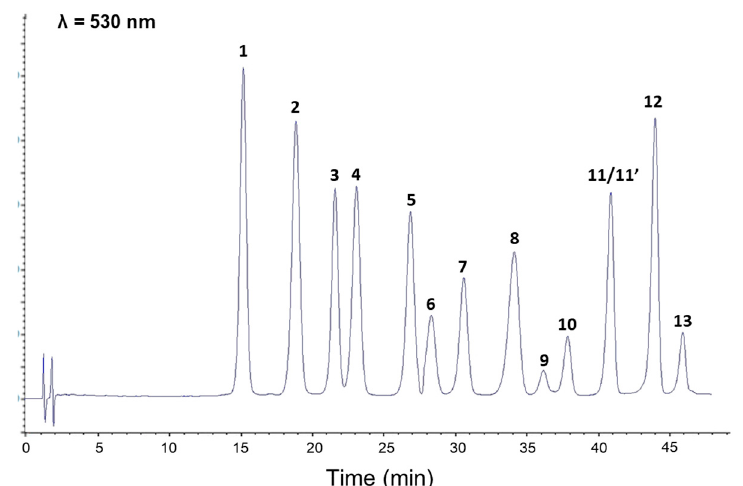
Figure 4. HPLC profile of Vaccinium myrtillus fruit extract. 1: delphinidin 3- O -galactoside, 2: delphinidin 3- O -glucoside, 3: cyanidin 3- O -galactoside, 4: delphinidin 3- O -arabinoside, 5: cyanidin 3- O -glucoside, 6: petunidin 3- O -galactoside, 7: cyanidin 3- O -arabinoside, 8: petunidin 3- O -glucoside, 9: peonidin 3- O -galactoside, 10: petunidin 3- O -arabinoside, 11: peonidin 3- O -glucoside, 11 ′ : malvidin 3- O -galactoside, 12: malvidin 3- O -glucoside, 13: malvidin 3- O -arabinoside.